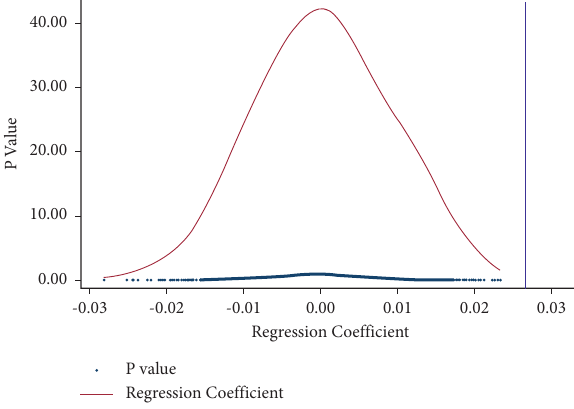
Figure 6: Estimated coefficients and p values of a treated group randomly sampled. Table 6: Regional differences in the effects of the Belt and Road Initiative on the unified economic and environmental efficiency of transportation